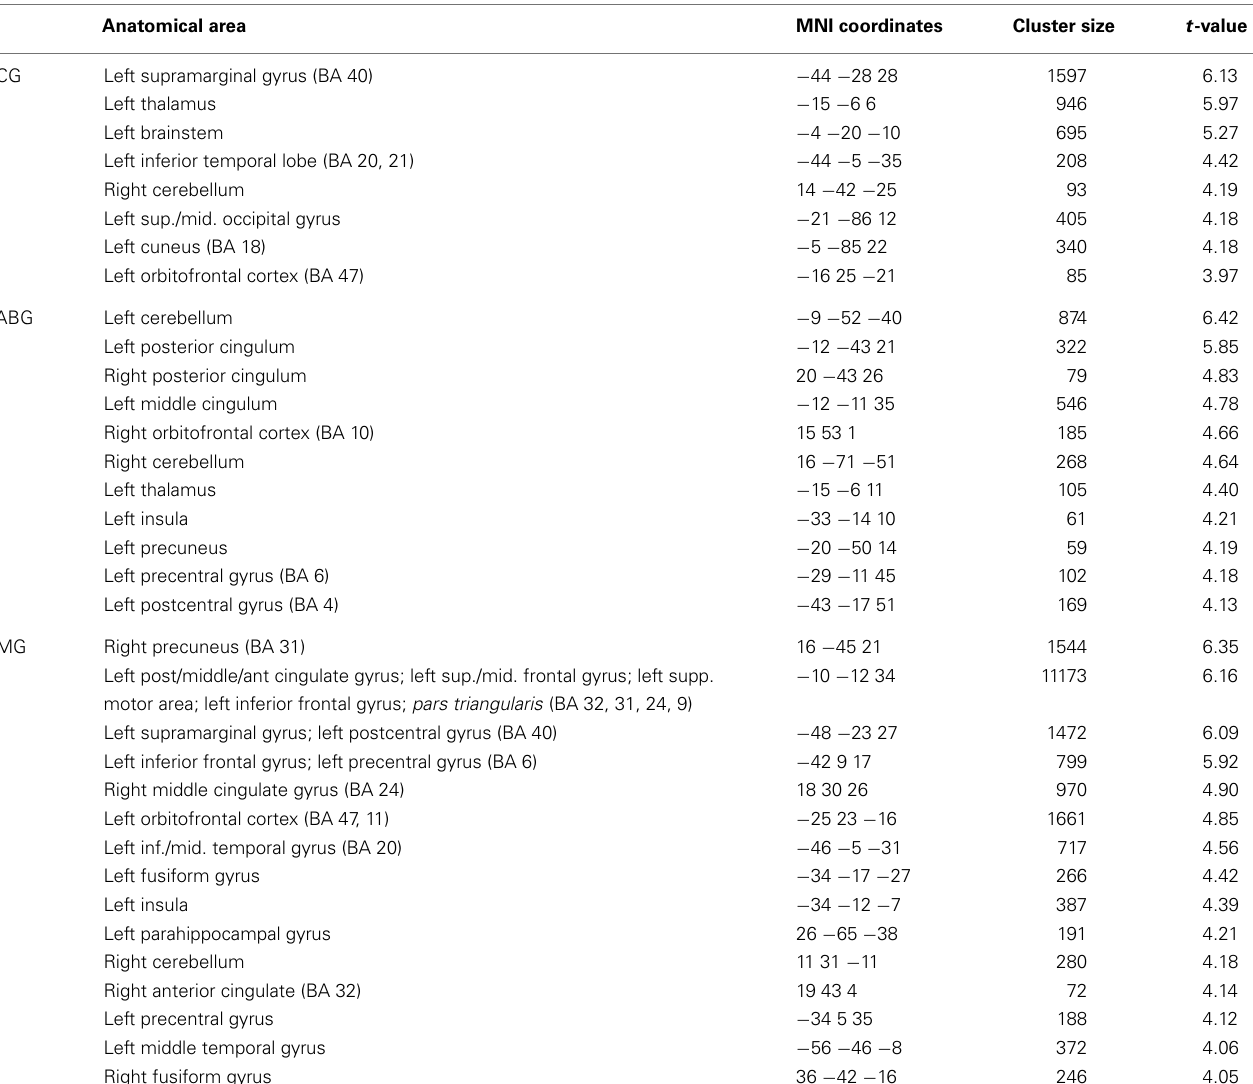
Table 4 | GMV increases (6-month − acute) in RHD patients ( n =